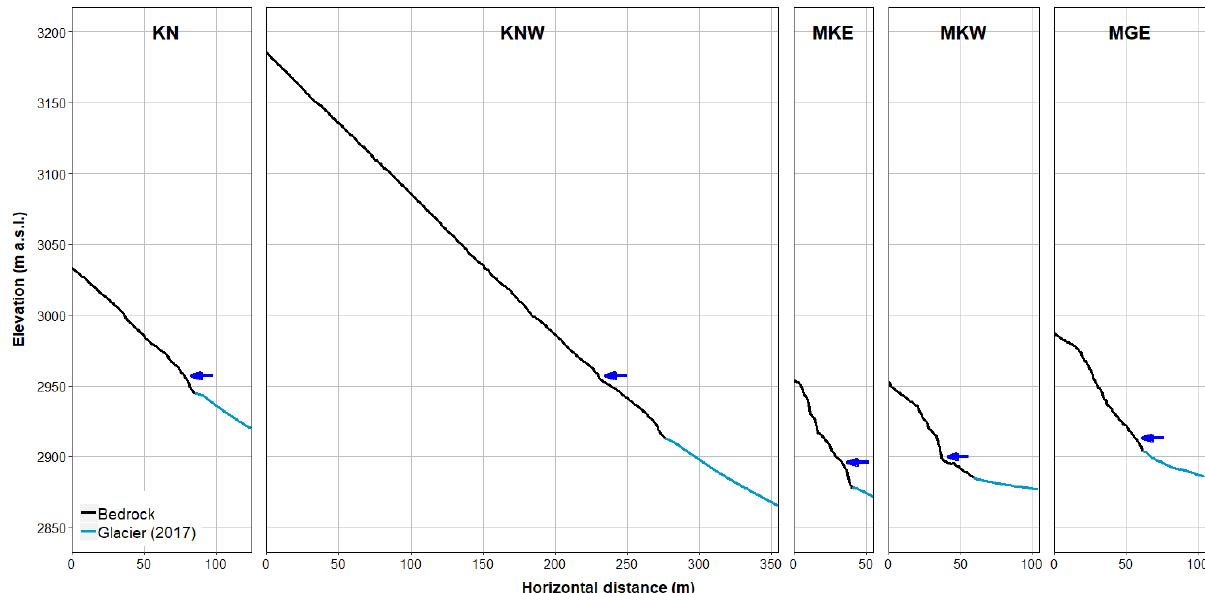
Figure 2. The 2-D slope profiles for all monitored rockwalls. Blue arrows indicate the approximate level of the glacier surface in 1953.